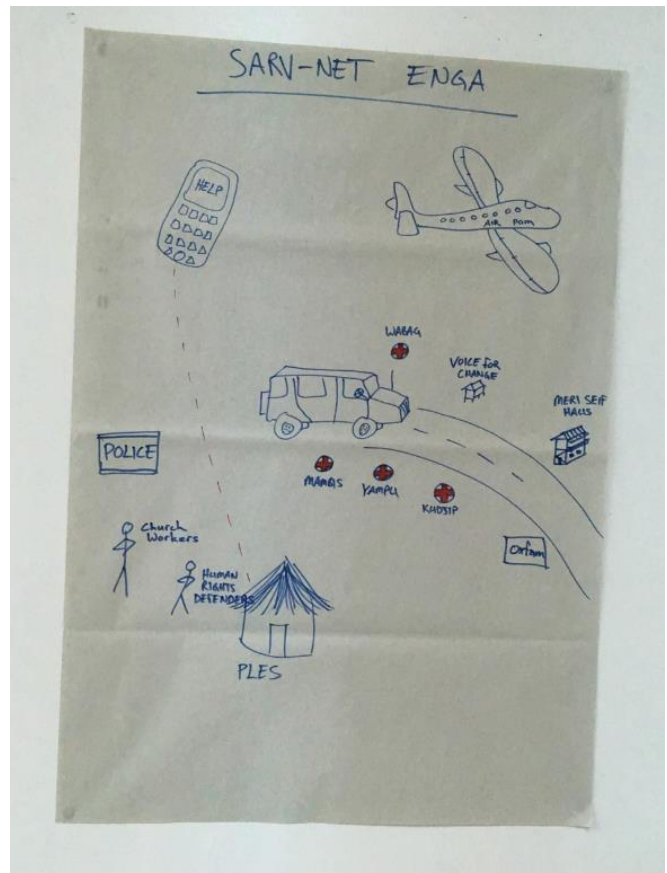
Figure 5: Pictorial representation of SARV network from SARV Workshop